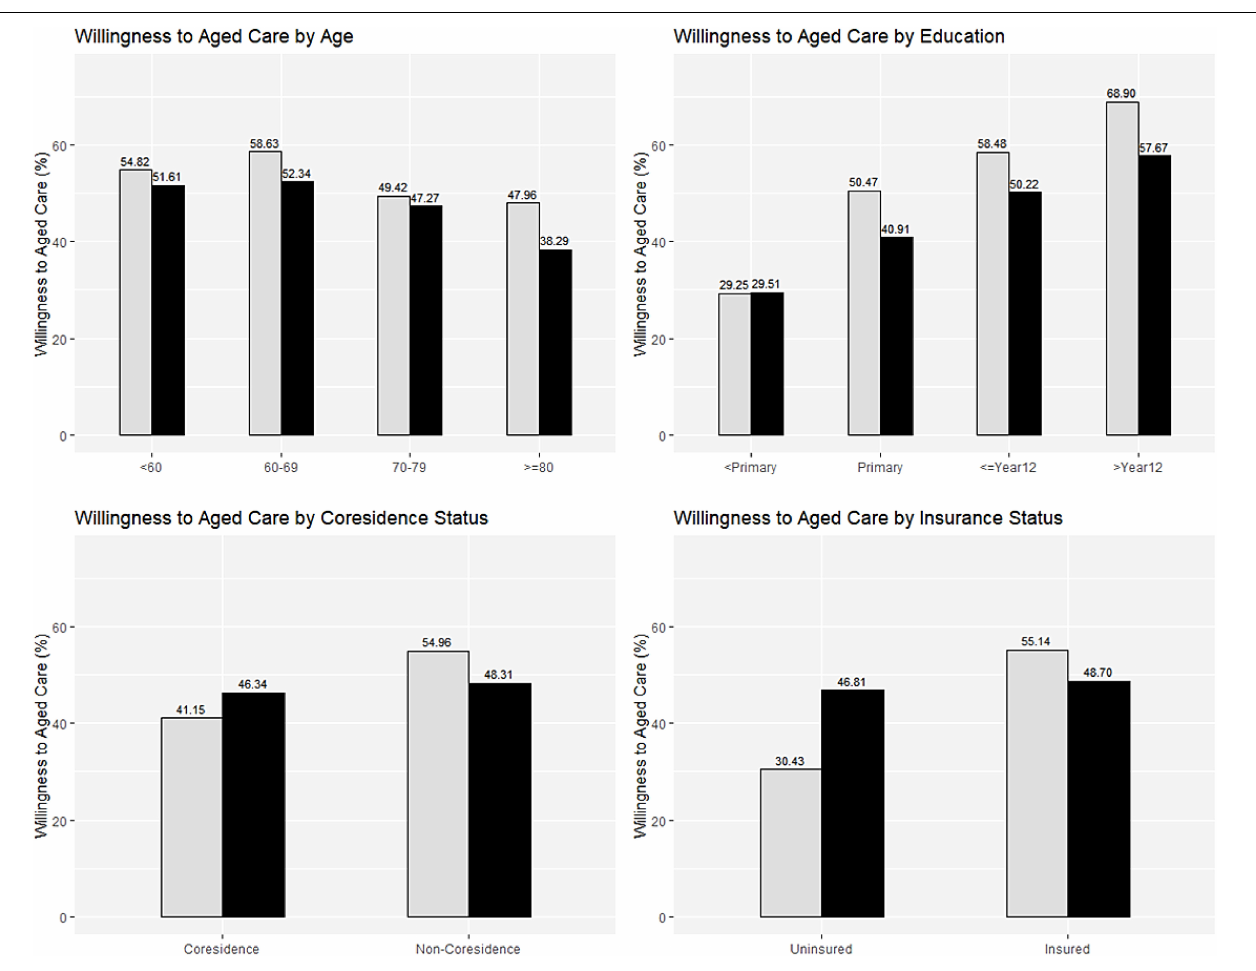
FIGURE 1 | Willingness to aged care by